Question: In one sentence, what is this figure communicating?
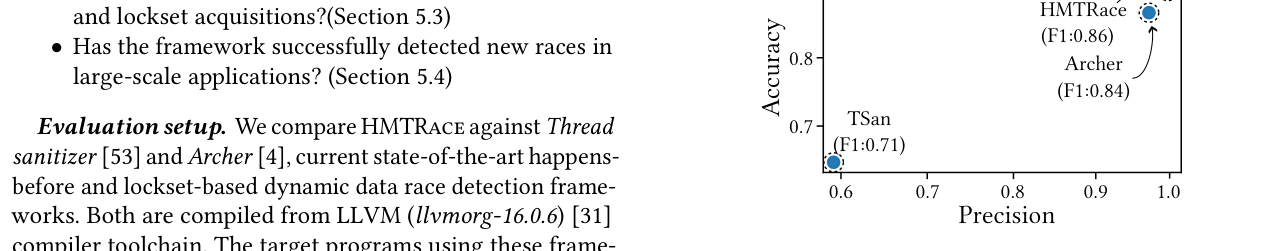
Answer: Precision and accuracy of the dynamic race detec- tion tools. The F1-score, representing the weighted average of precision and accuracy, is listed within parentheses.